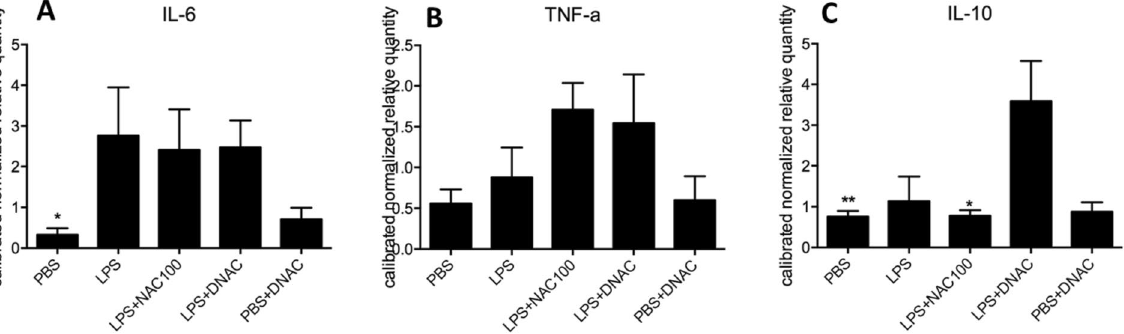
Figure 2. DNAC suppresses inflammatory response in the placenta. cDNA was prepared from RNA isolated from placentas ( A – C ) at 6 hours post-surgery, and RT-qPCR was performed to assess cytokine gene expression. Cytokine expression was normalized to 18S ribosomal, β -actin, GAPDH, and HPRT RNA expression. DNAC treatment significantly increased the expression of IL-6 and IL-10 in LPS-exposure group, compared to PBS control ( A and C ). There were no significant changes between PBS and PBS + DNAC group for IL-6, TNF – α and IL-10 expression. Data was log transformed for statistical analysis. ( * p < 0.05 vs LPS + DNAC, ** p < 0.01 vs LPS + DNAC); One-way ANOVA with Newman-Keuls for multiple comparisons; n = 6 PBS litters, 3 LPS litters, 5 LPS + DNAC litters, 5 PBS + DNAC litters, 5 LPS + NAC100 litters). GAPDH, Glyceraldehyde 3-phosphate dehydrogenase; HPRT, hypoxanthine phosphoribosyltransferase